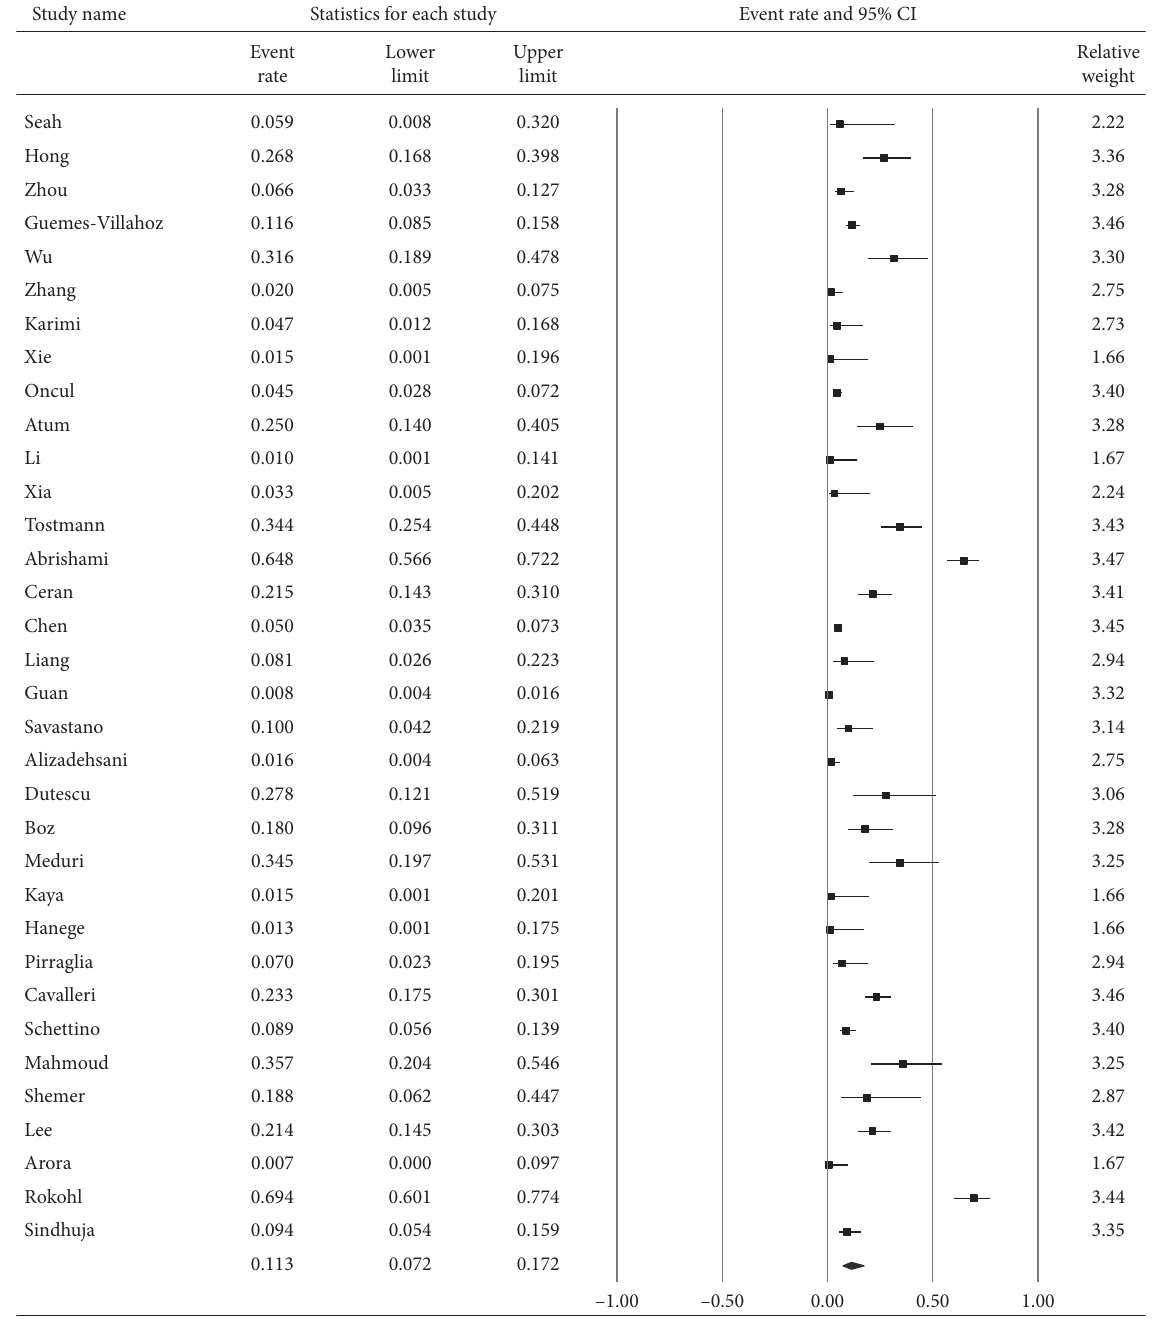
Figure 2: The overall prevalence of ocular manifestations of included